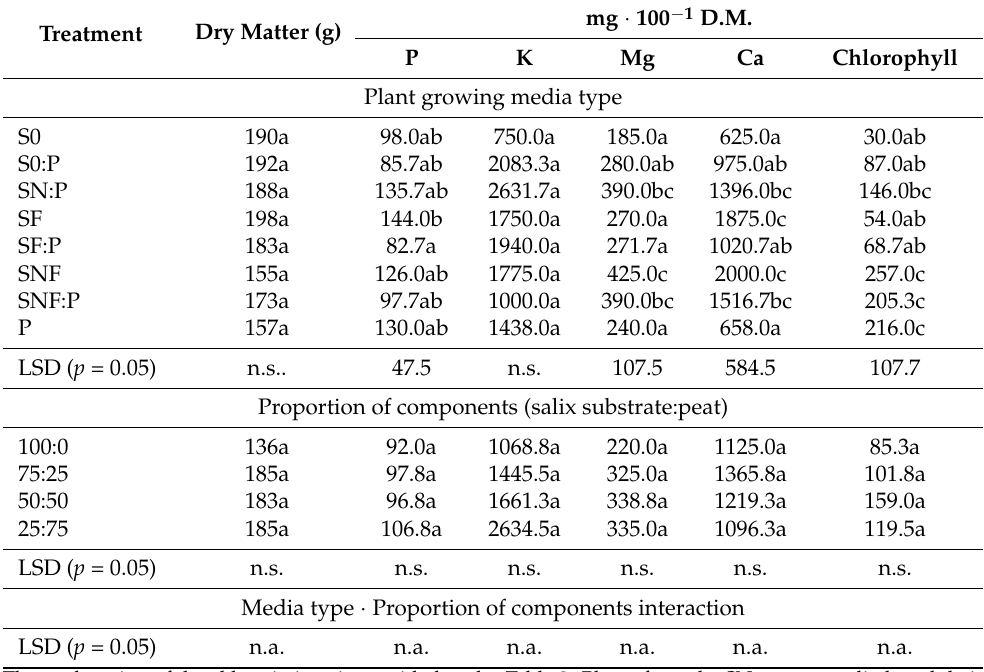
Table 8. The effect of horticulture media on transplants chemical composition.